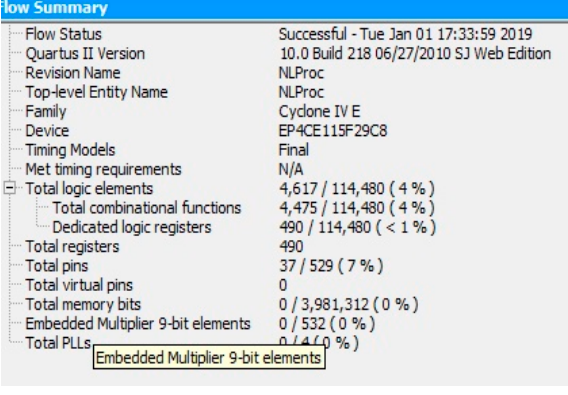
Figure 11. Hardware utilization of language processor.